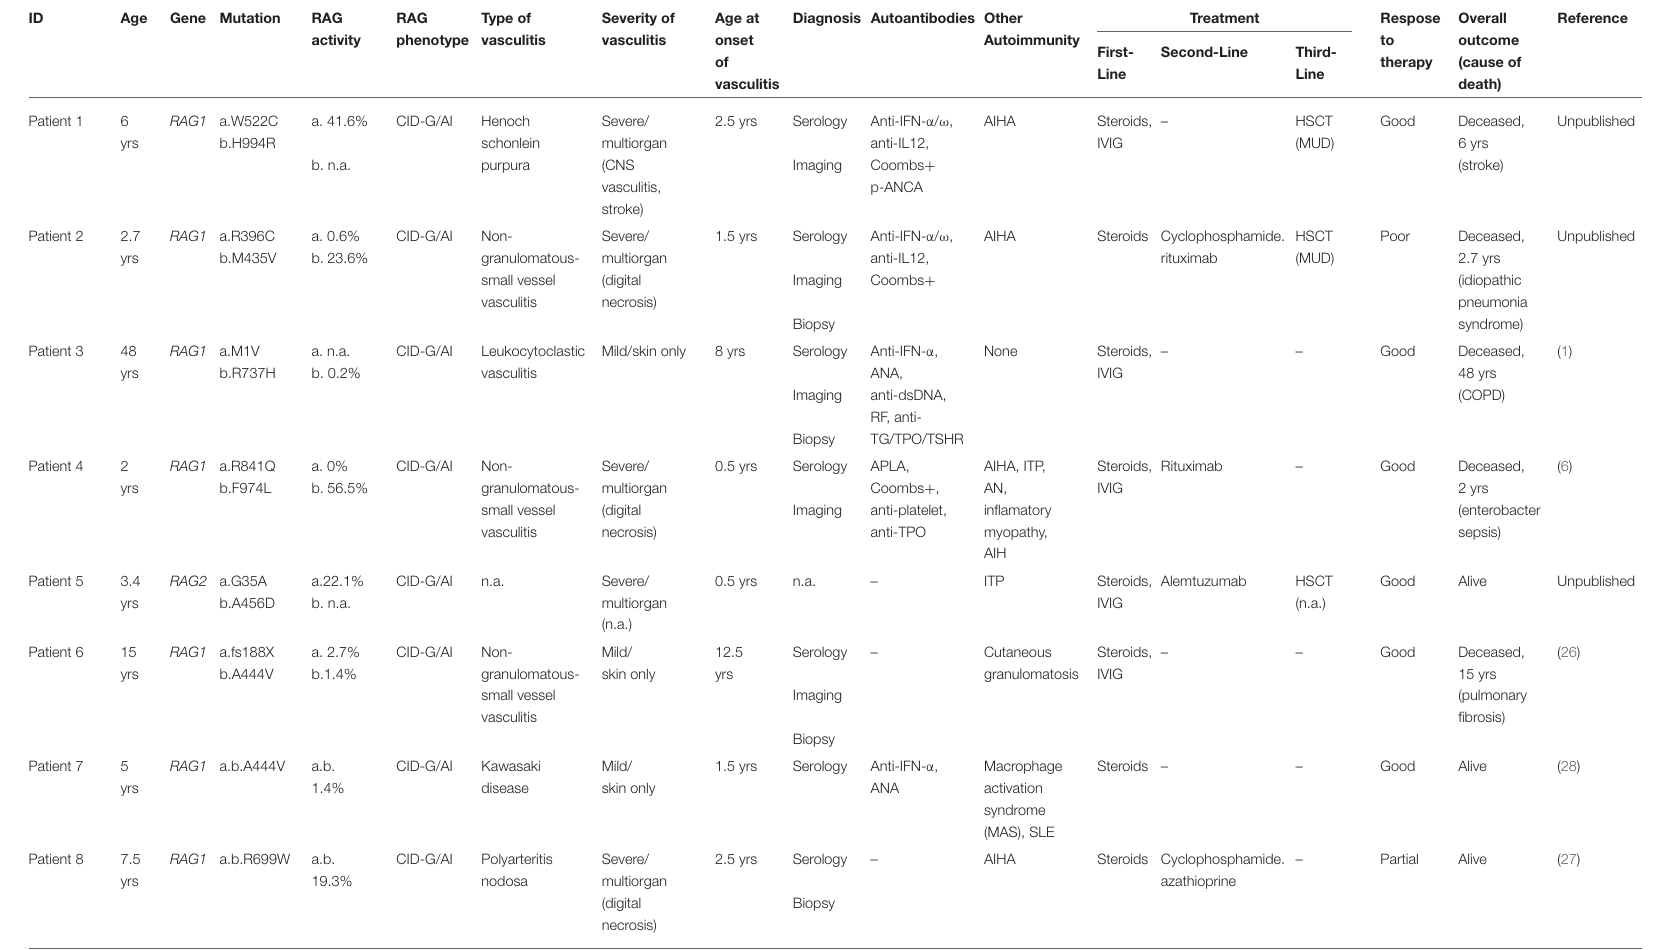
TABLE 1 | Detailed clinical information on patients with vasculitis due to RAG